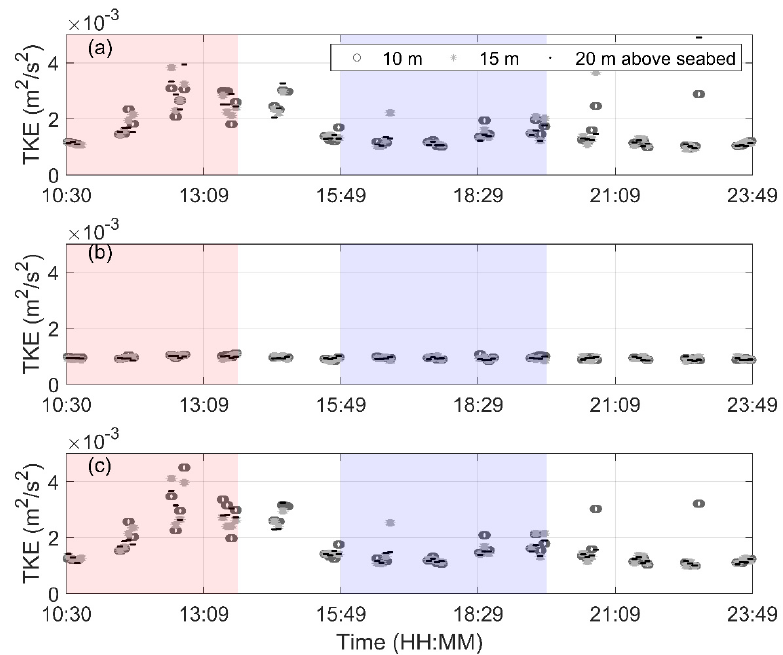
Figure 10. Vertical TKE estimated from vertical beam measurements using ( a ) the SB, ( b ) MA, and ( c ) SWT decomposition methods at bottom tip height (10 m above seabed), hub-height (15 m above seabed), and top tip (20 m above seabed). Time-series show an approximately 12-hours period measured on the 26th April 2018 at measurement location CWTb1.